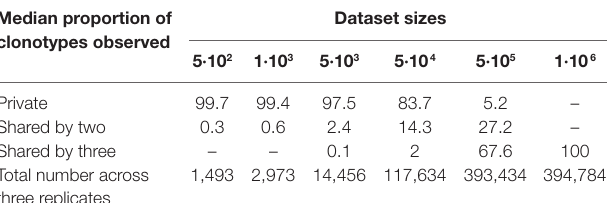
TaBle 3 | Sharing proportion between three replicates.